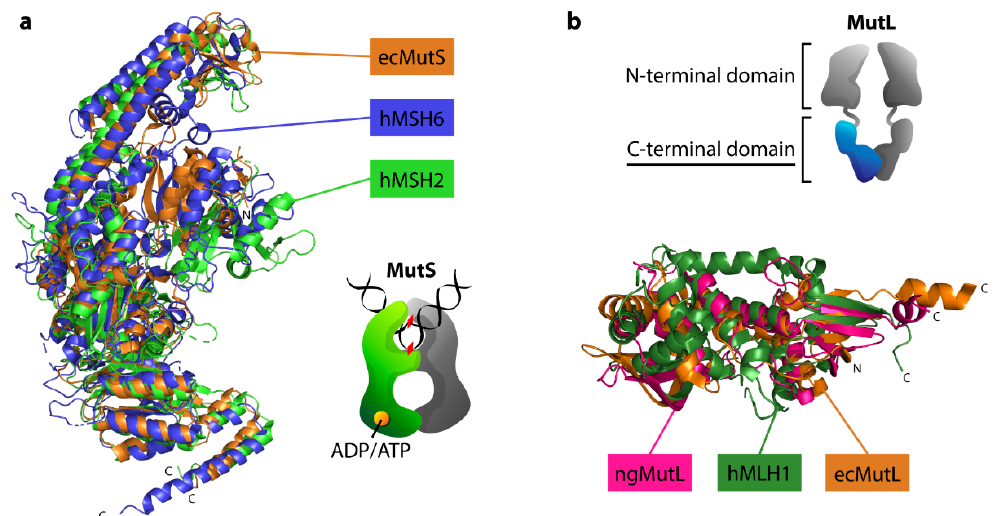
Figure 6. Superposition of crystal structures of MutS and MutL homologs. ( a ) Superposition of ecMutS (PDB ID 1E3M) and MSH6/MSH2 MutS α subunits from H. sapiens (PDB ID 2OF8). ecMutS, hMSH2, and hMSH6 are colored orange, light-green, and blue, respectively. ( b ) Superposition of hMLH1, ngMutL, and ecMutL C-terminal domains (PDB IDs 3RBN, 3NCV, 1X9Z, respectively). hMLH1, ngMutL, and ecMutL are shown in green, pink, and orange, respectively.